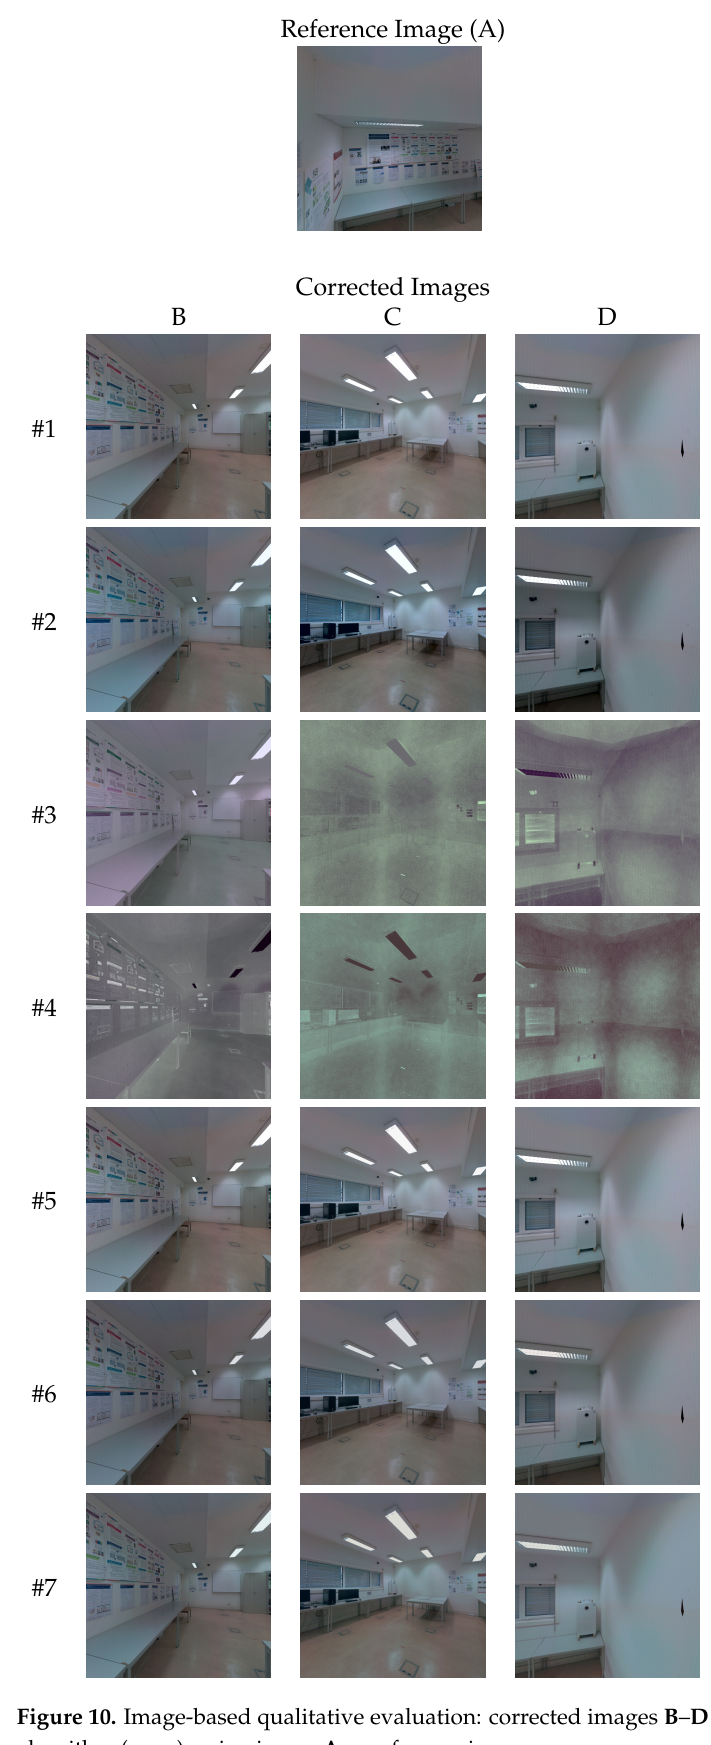
Figure 10. Image-based qualitative evaluation: corrected images B – D (columns) produced by each algorithm (rows), using image A as reference